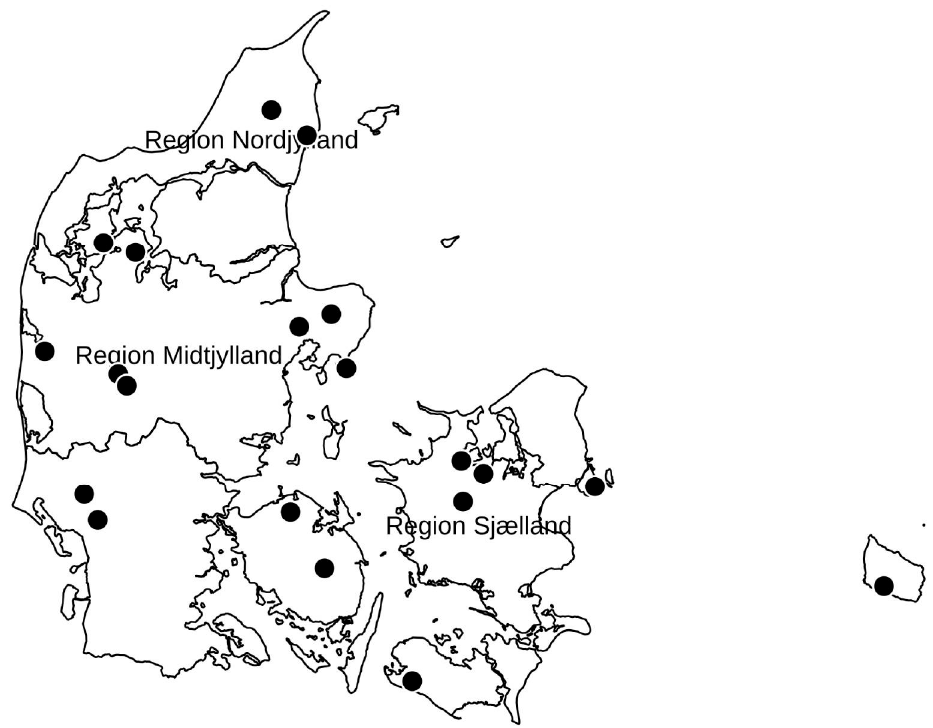
Figure 1. Spatial distribution of the selected set of fields across Denmark.